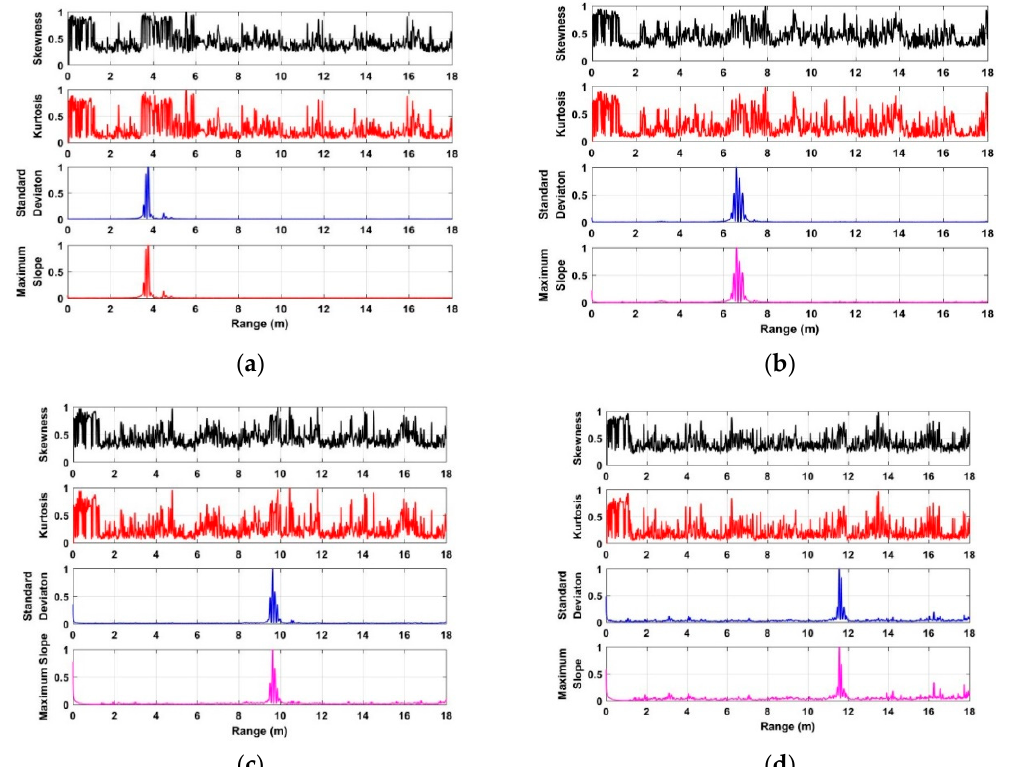
Figure 11. The distance estimates based on the acquired data from the actuator at distances of ( a ) 4 m; ( b ) 7 m; ( c ) 10 m; and ( d ) 12 m indoors.